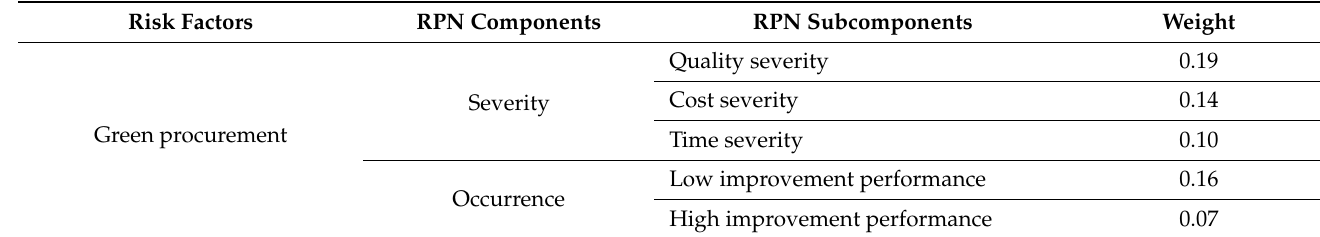
Table 3. The weights for each RPN